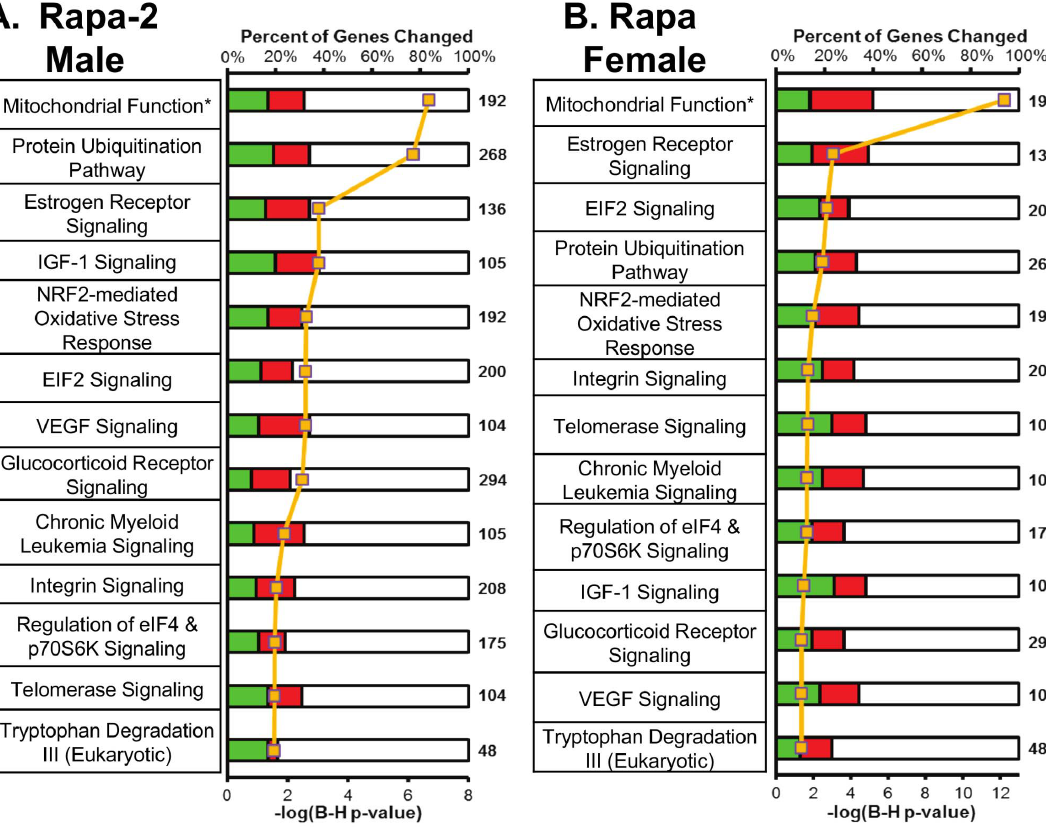
Figure 5. Pathway analysis indicates that male and female mice fed Rapa share 13 pathways. Pathway analysis was conducted using IPA for significantly changed transcripts in Rapa-2 males and Rapa females relative to respective sex controls with adjusted p , 0.05 and 15% change. IPA used Fisher’s exact test to place genes into pathways, and we also used a FDR cutoff of B-H p , 0.05 to show the highly significant pathways. The 13 shared pathways ranked by B-H p-value are shown for Rapa-2 males ( A ) and Rapa females ( B ). For the graphical portion of A and B, the yellow line indicates the –log(B-H p-value). Red indicates up-regulated and green represents down-regulated genes significantly changed in Rapa compared to control, and white indicates the percentage of genes not significantly changed in the pathway relative to the total number of genes in that pathway (bolded number). Twenty-four other pathways were observed to change significantly in Rapa-2 males: acute phase response signaling, hypoxia signaling, PI3K/AKT signaling, remodeling of epithelial adherens junctions, sertoli cell-sertoli cell junction signaling, renal cell carcinoma signaling, JAK/Stat signaling, IL-3 signaling, myc mediated apoptosis Signaling, germ cell-sertoli cell junction signaling, pancreatic adenocarcinoma signaling, insulin receptor signaling, non-small cell lung cancer signaling, Rac signaling, small cell lung cancer signaling, PTEN signaling, prostate cancer signaling, neurotrophin/TRK signaling, PAK signaling, RAR activation, NGF signaling, clathrin-mediated endocytosis signaling, huntington’s disease signaling, and TCA cycle II. Six other pathways were observed to change significantly in Rapa females: systemic lupus erythematosus signaling, mTOR signaling, actin nucleation by ARP-WASP complex, superpathway of methionine degradation, glutathione-mediated detoxification, and oncostatin M signaling. A list of the pathways that significantly changed with chronic Rapa feeding is shown in in File S2, tab2 for Rapa-2 male; tab3 for Rapa female and the transcripts that change for the 13 shared pathways are found in File S3. The asterisk indicates that the mitochondrial function pathway is indicated as mitochondrial dysfunction in IPA. The mitochondrial dysfunction pathway described in IPA is somewhat misleading because it contains genes involved in mitochondrial function in general, e.g., genes in the electron transport chain complexes and redox and antioxidant enzymes as well as other genes related to mitochondrial